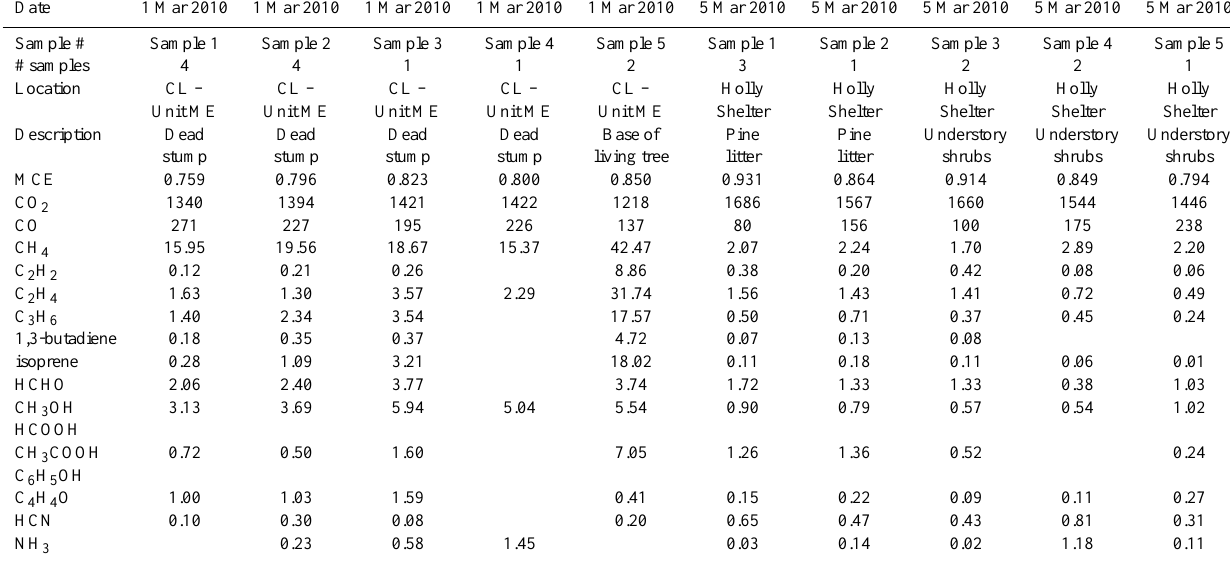
Table 5. Ground-based MCE and emission factors (gkg − 1